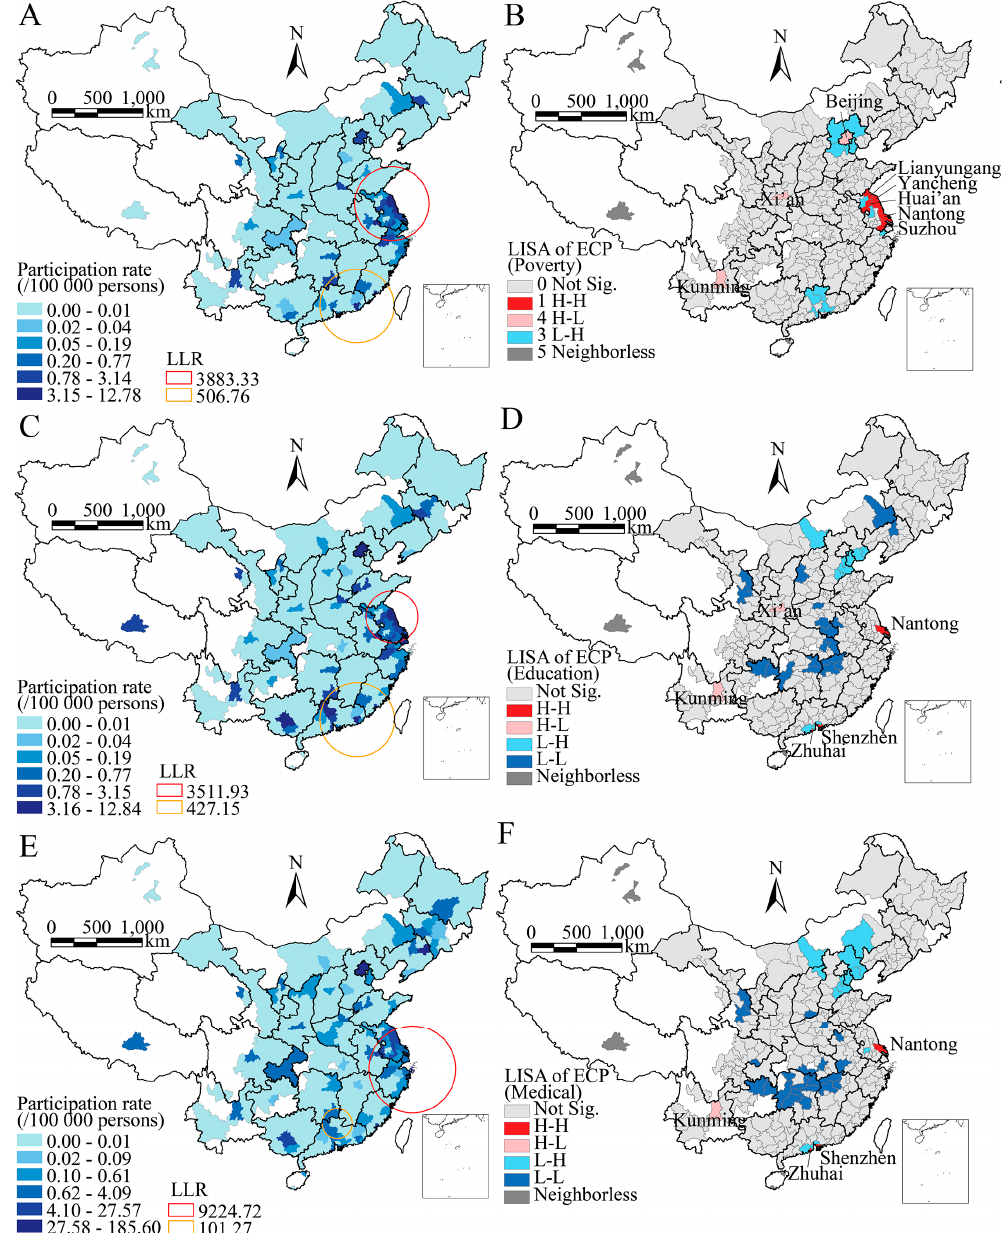
Figure 5. Spatial clusters of charity participation rate explored by spatial scan statistics ( A , C , E ) and the charity expenditures of local foundations detected by local indicator of spatial association (LISA) ( B , D , F ).